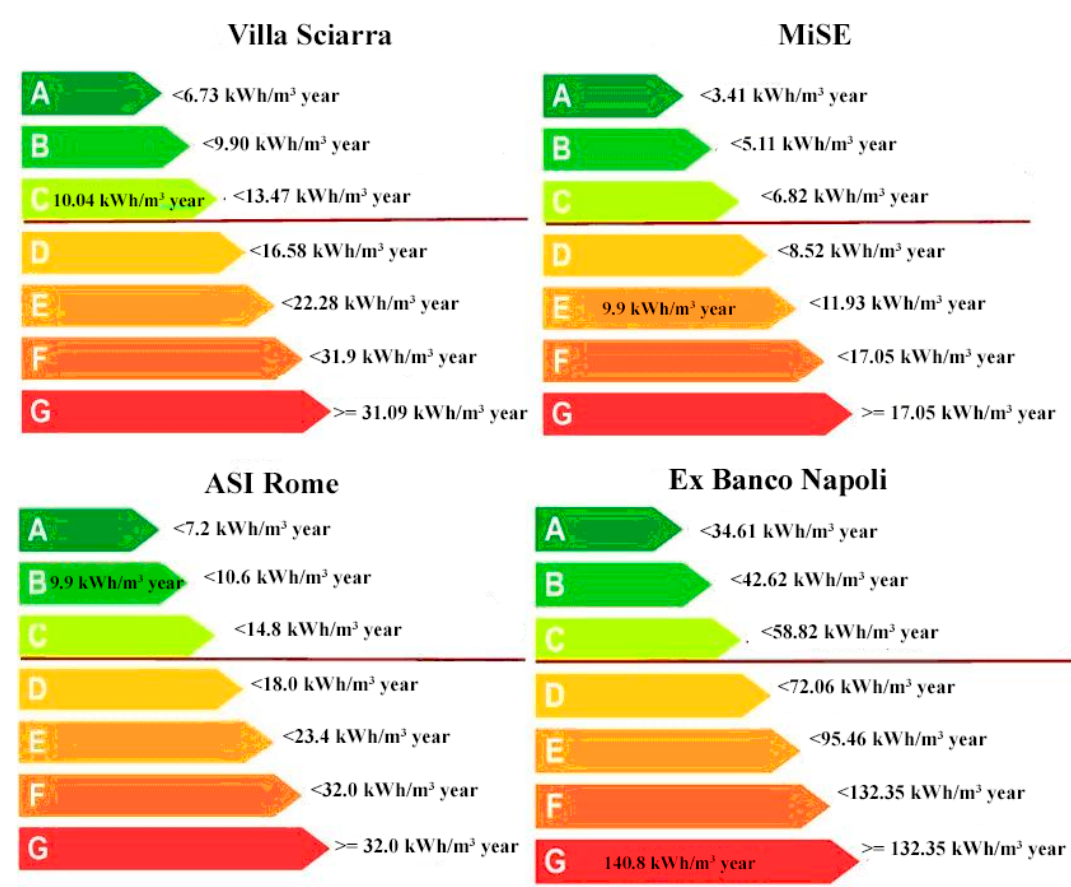
Figure 2. Actual energy performance of the analyzed buildings ( EP gl values).